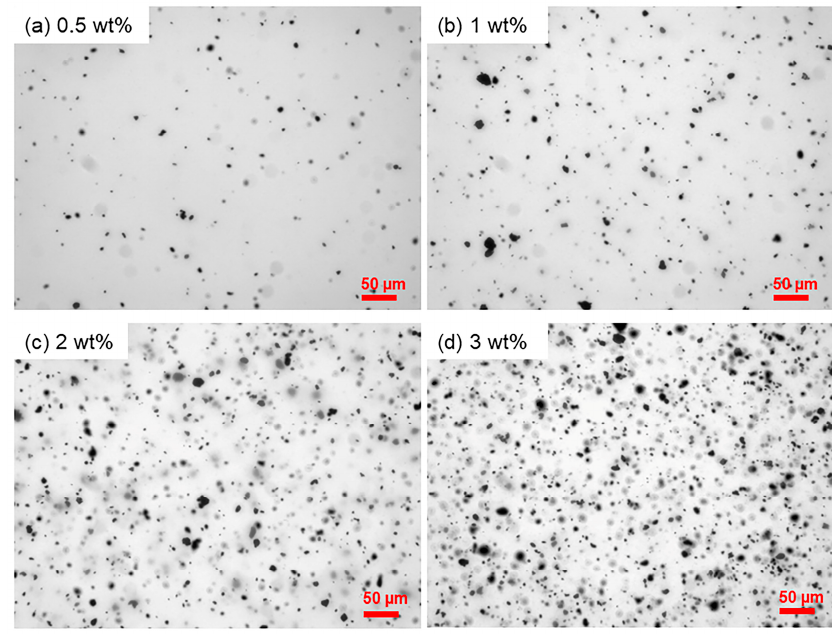
Figure 2. Optical microscopy images (20 × objective) of MWCNT-COOH dispersion in the PNIPAM gel obtained by the first photopolymerization step. Concentration of nanotubes equal to ( a ) 0.5 wt%, ( b ) 1 wt%, ( c ) 2 wt%, ( d ) 3 wt%.